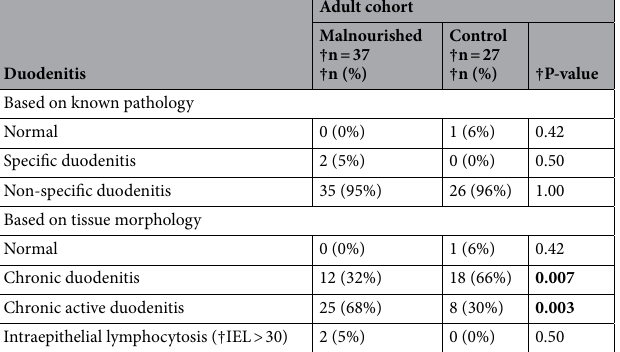
Table 2. Distribution of duodenitis based on the operational classification. † n Number of respondents, P-value Significance level, IEL Intraepithelial lymphocytosis. Tests used ; Pearson’s Chi-Square test, Fisher’s Exact Test.